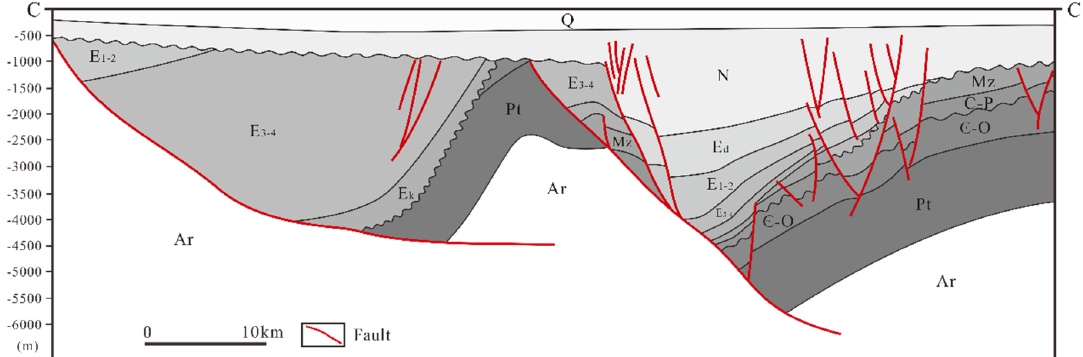
Figure 2. A geological cross-section in the Jizhong Sub-Basin, showing the structural pattern of the strata (modified according to He et al., 2017) [36]. The position of the cross-section is shown by C-C’ in Figure 1.